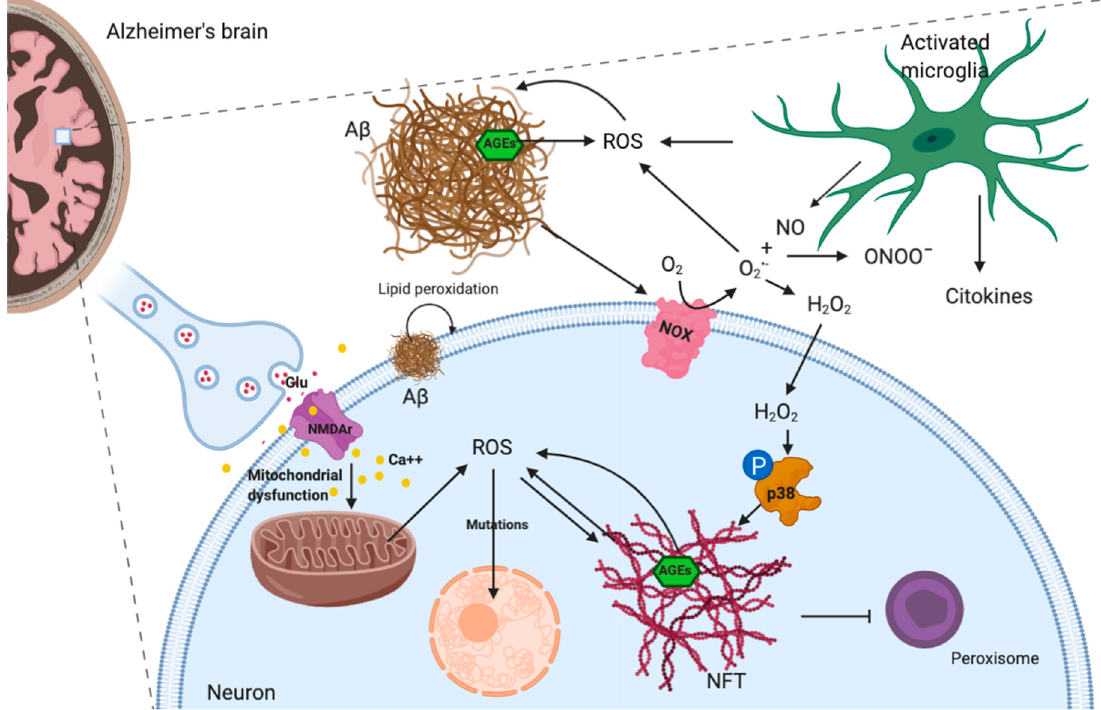
Figure 2. Schematic representation of ROS sources and their molecular targets in AD. Image created with BioRender.com.